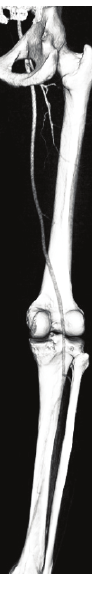
Figure 1: Computerized tomography angiography indicated giant pseudoaneurysm of the superficial femoral artery (posterior view).